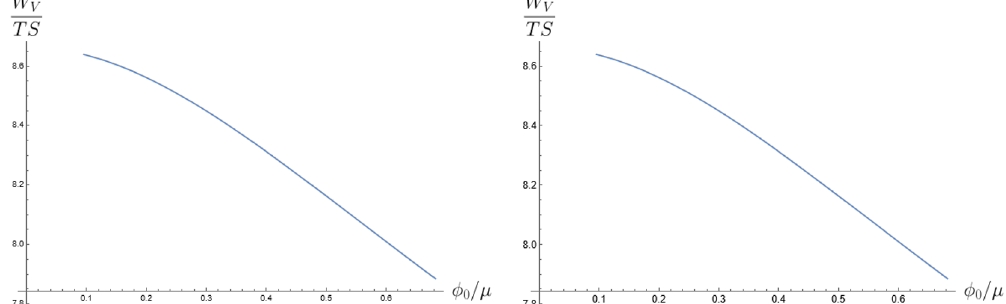
Figure 13 . Left: asymptotic volume complexity for charged solutions with q = 1 at constant T/µ = 0 . 15 . Right: asymptotic volume complexity for uncharged solution at T/µ = 0 . 25 . where M D,N are in eqs. (D.7), (D.9). We find that the bound is satisfied in all